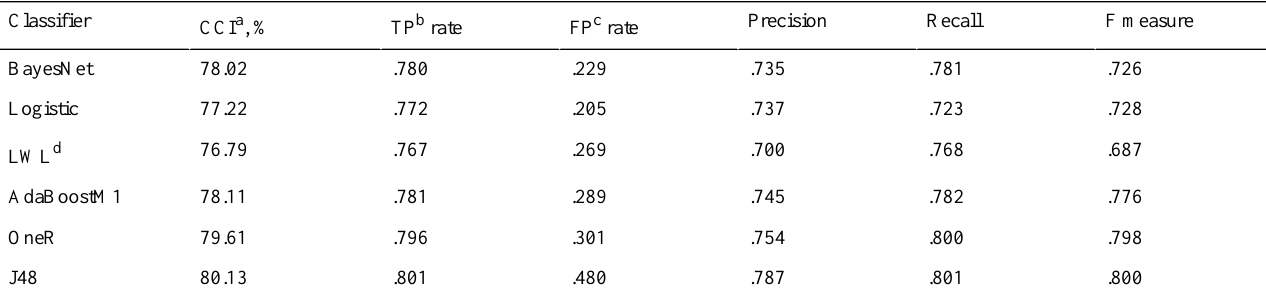
Table 10. Predicting attitude based on perceived usefulness.